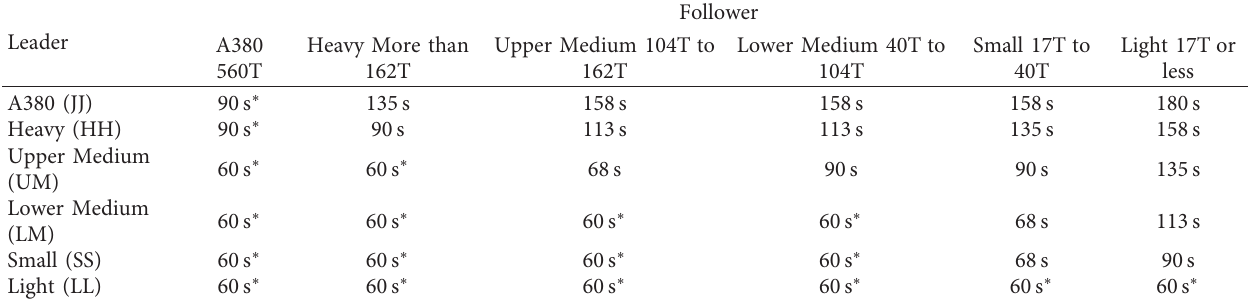
Table 11: Time separation operation standard of coastal airports in China.